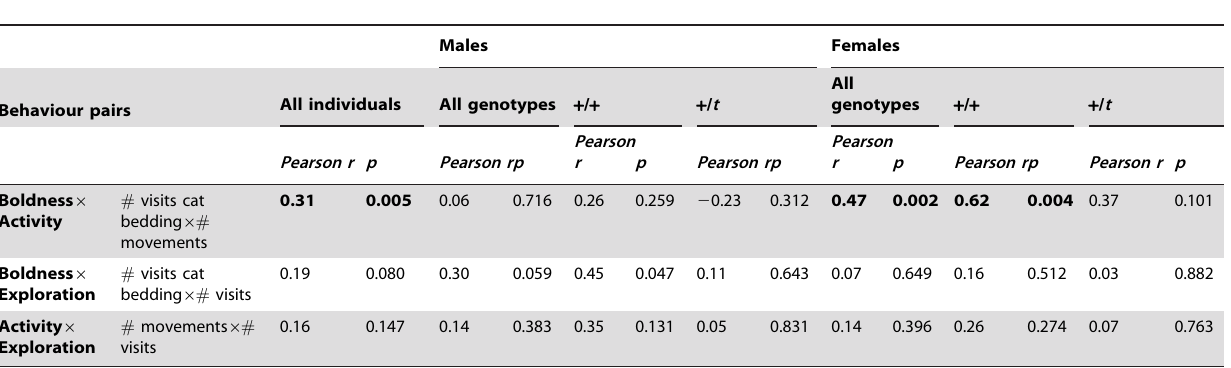
Table 3. Correlations between personality traits showing individual consistency.